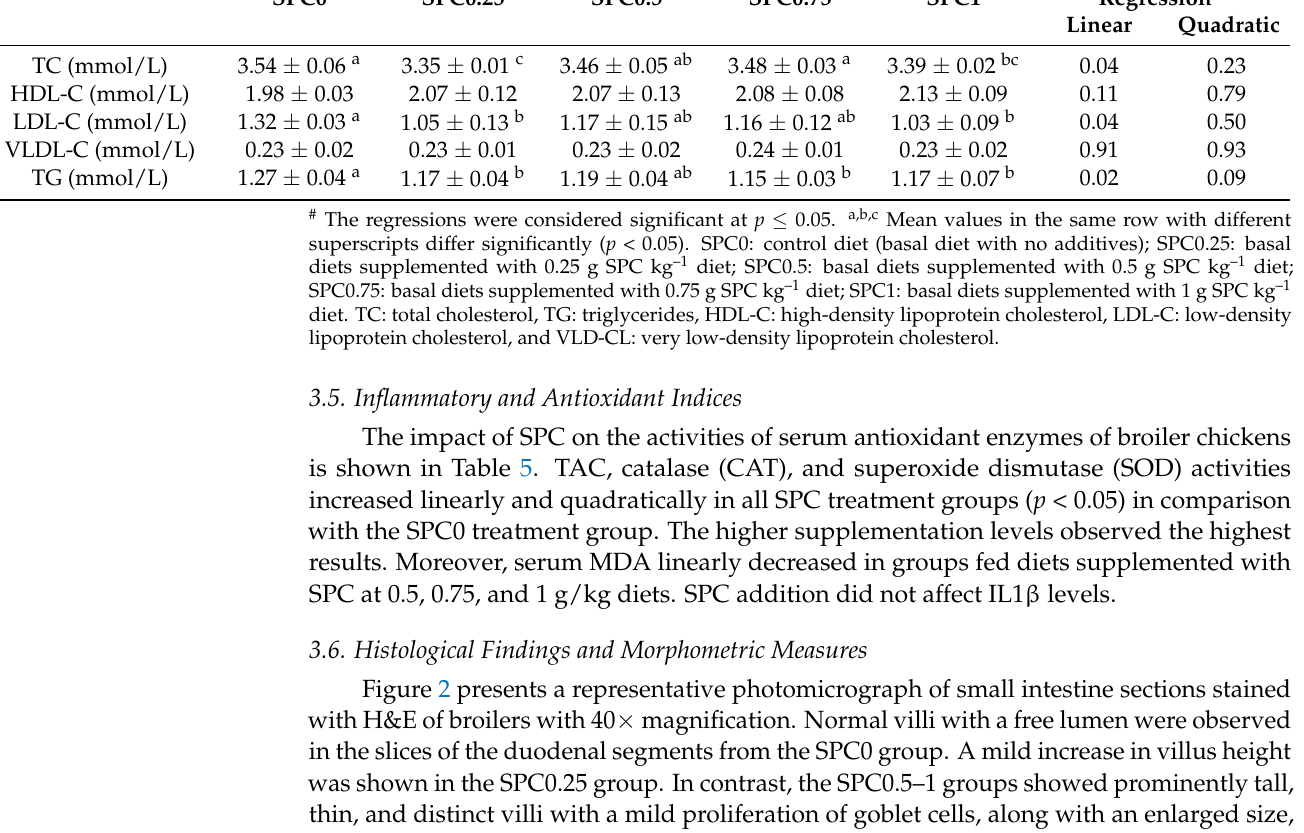
Table 4. Effect of dietary Spirulina platensis phycocyanin addition on serum lipid profile.